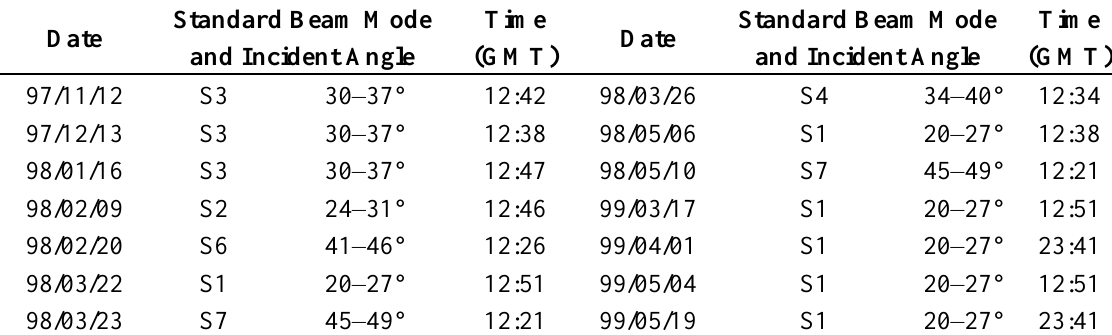
Table 1. The date, hour and acquisition mode of the RADARSAT-1 images. Standard Beam